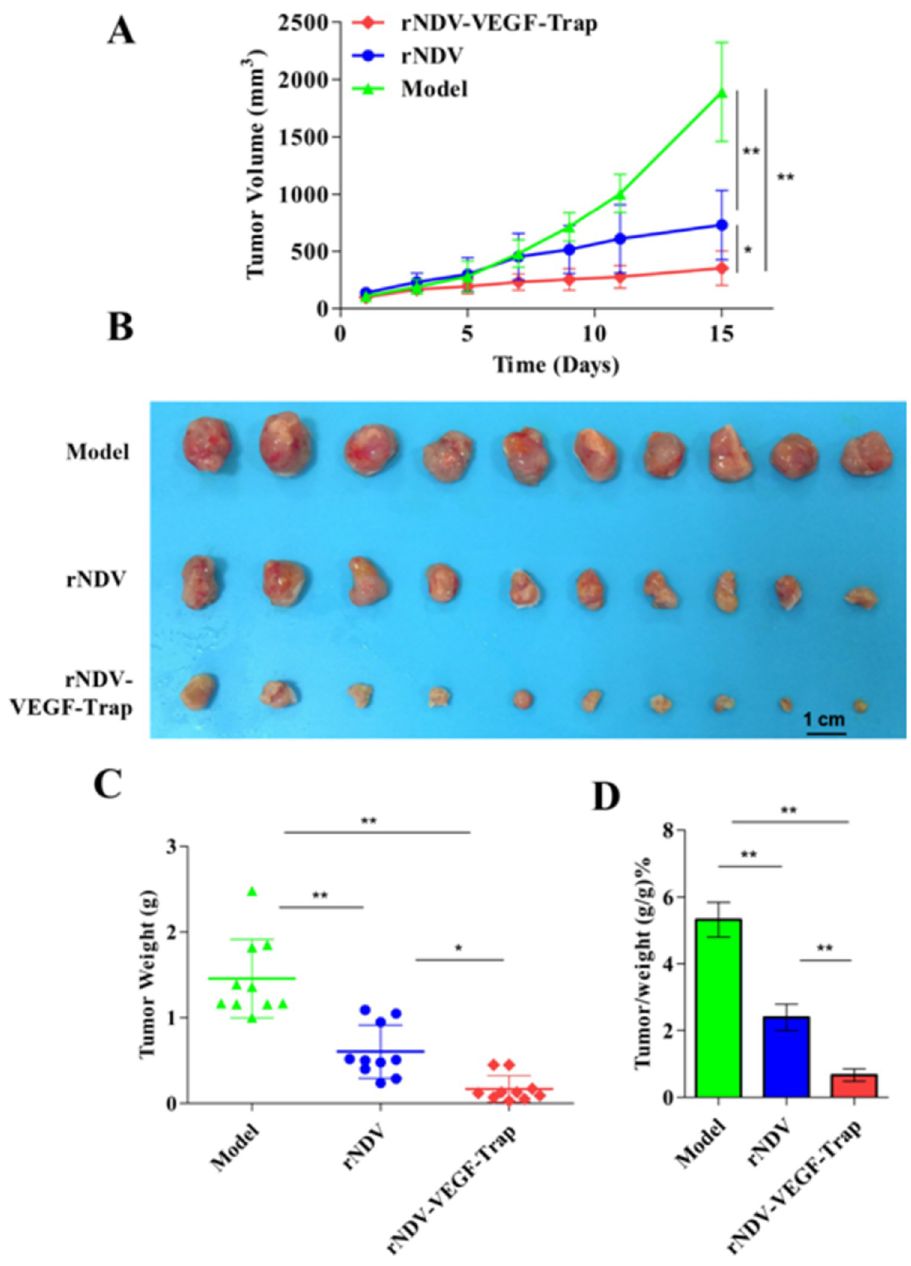
Fig 3. rNDV-VEGF-Trap further suppresses tumor growth of CT26-bearing mice. Six-week-old female BALB/c mice were injected with 10 6 CT26 cells in the right groin. When the tumor size reached about 100 mm 3 , the mice were intratumorally treated with rNDV or rNDV-VEGF-Trap at 10 7 pfu. The mice were euthanized and necropsy was performed after 15 days of treatment. (A) The tumor volume of CT26-bearing mice was measured in two dimensions every other day using digital calipers. (B) Tumor collected at the end of the experiment. (C) Tumor Weight. (D) The ratio of tumor weight to body weight. Model: mice treated with allantoic fluid ( n = 10); ns: no significance; � P < 0.05; �� P <